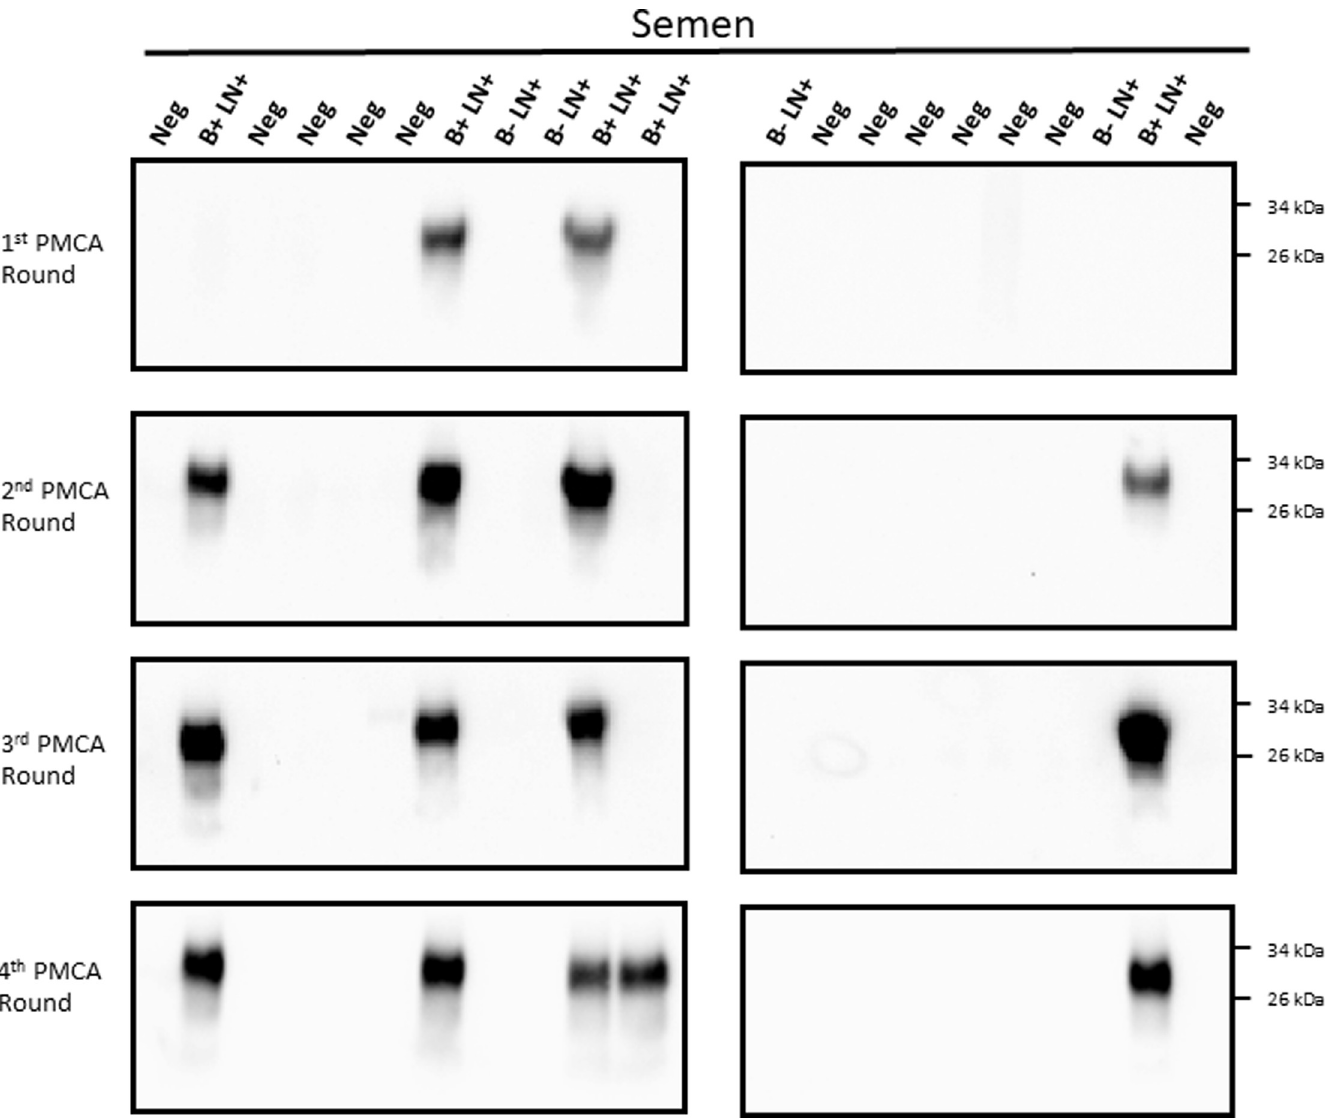
Fig 1. CWD prion detection in semen samples from white-tailed deer. Twenty-one semen samples from farmed white tailed-deer were tested for their presence of CWD prions by PMCA. Four serial PMCA rounds were performed to increase sensitivity. B+ LN+: had PrP Sc deposition in the brain stem and medial retropharyngeal lymph nodes (MRPLN) by immunohistochemistry (late pre-symptomatic); B- LN+: had PrP Sc deposition only in the MRPLN (early pre-symptomatic); Neg: samples were non-detect for CWD in both the brain stem and the MRPLN. Numbers at the right represent molecular weight markers.